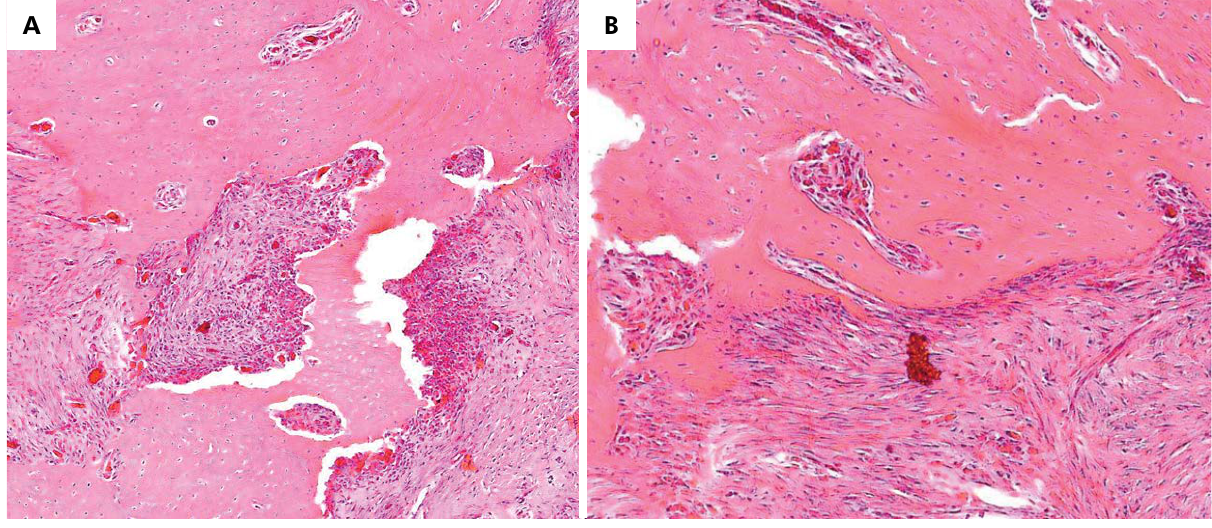
Figure 3. Histologic findings of tooth socket after eight weeks. A: Infiltration of inflammatory cells with non-vital bone was observed in the control group. B: Normal bone remodeling was observed with formation of a new blood vessel in the experimental group. Hematoxylin-eosin stain,